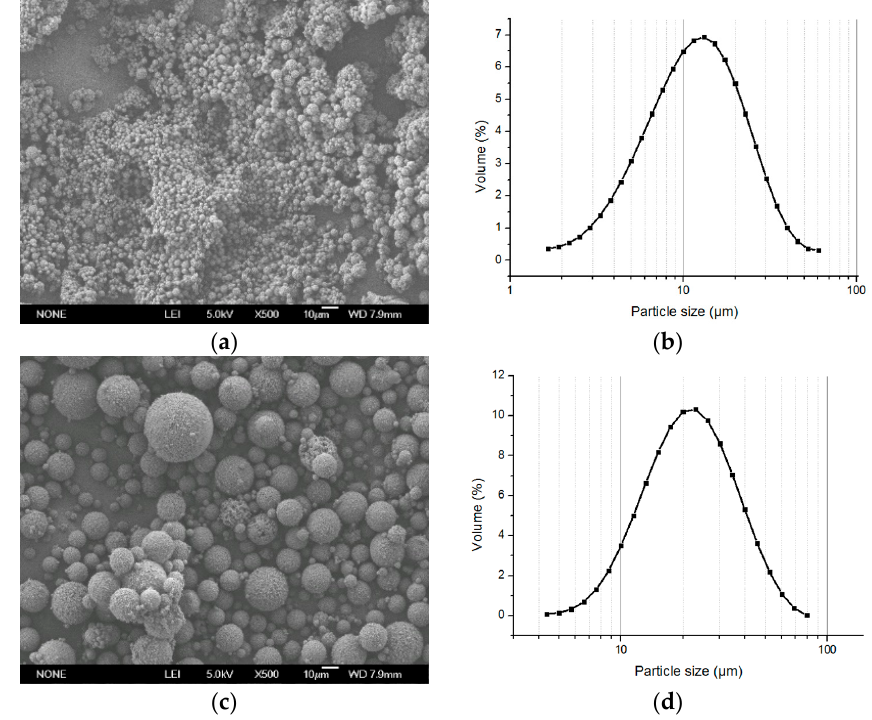
Figure 4. The photographs of the microspheres made at different stirring speeds. Stirring speed 150 rpm, swelling time 10 min ( a ) SEM image (×500) and ( b ) particle size distribution (dispersed). Stirring speed 70 rpm, swelling time 10 min ( c ) SEM image ( ˆ 500) and ( d ) particle size distribution (dispersed).